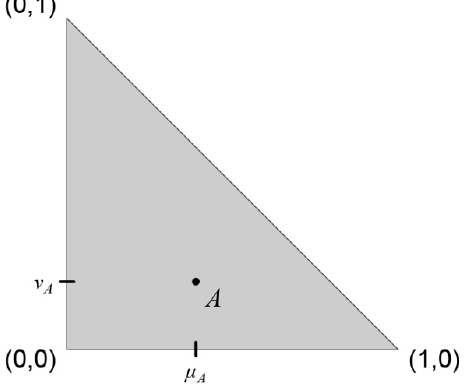
Figure 2. IFS-interpretational